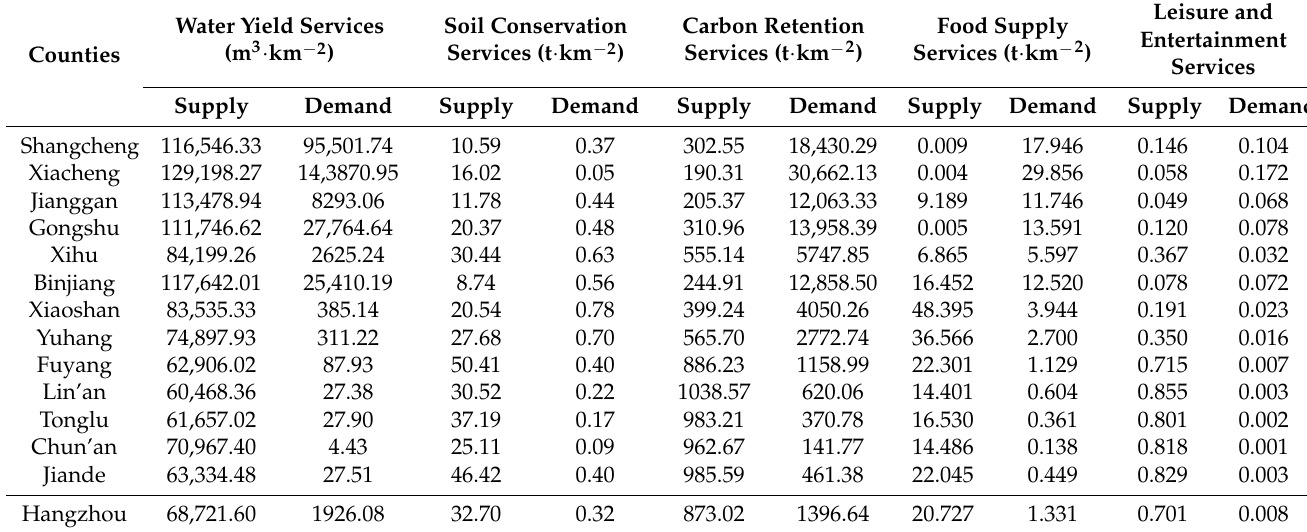
Table 1. Status of supply and demand of ESs in